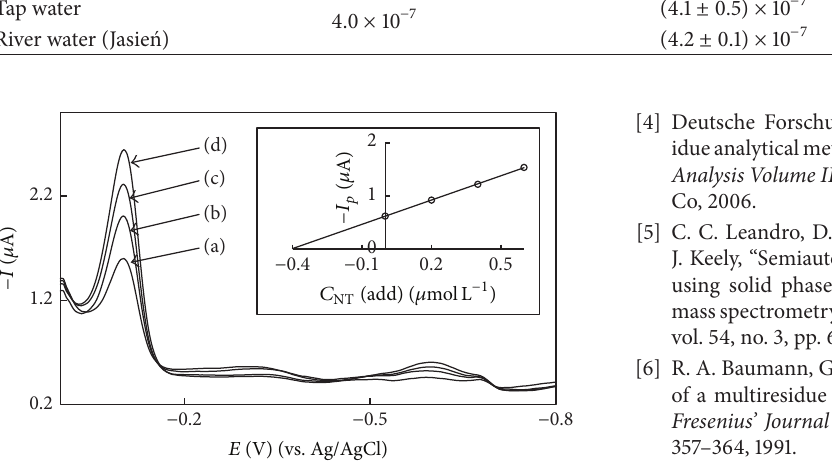
Figure 5: SWAdS voltammograms of nitrothal-isopropyl determi- nation in spiked tap water samples using the standard addition method ((a) sample; (b), (c), and (d) standard additions). Experi- mental conditions are the same as in Figure 4. Inset: corresponding calibration